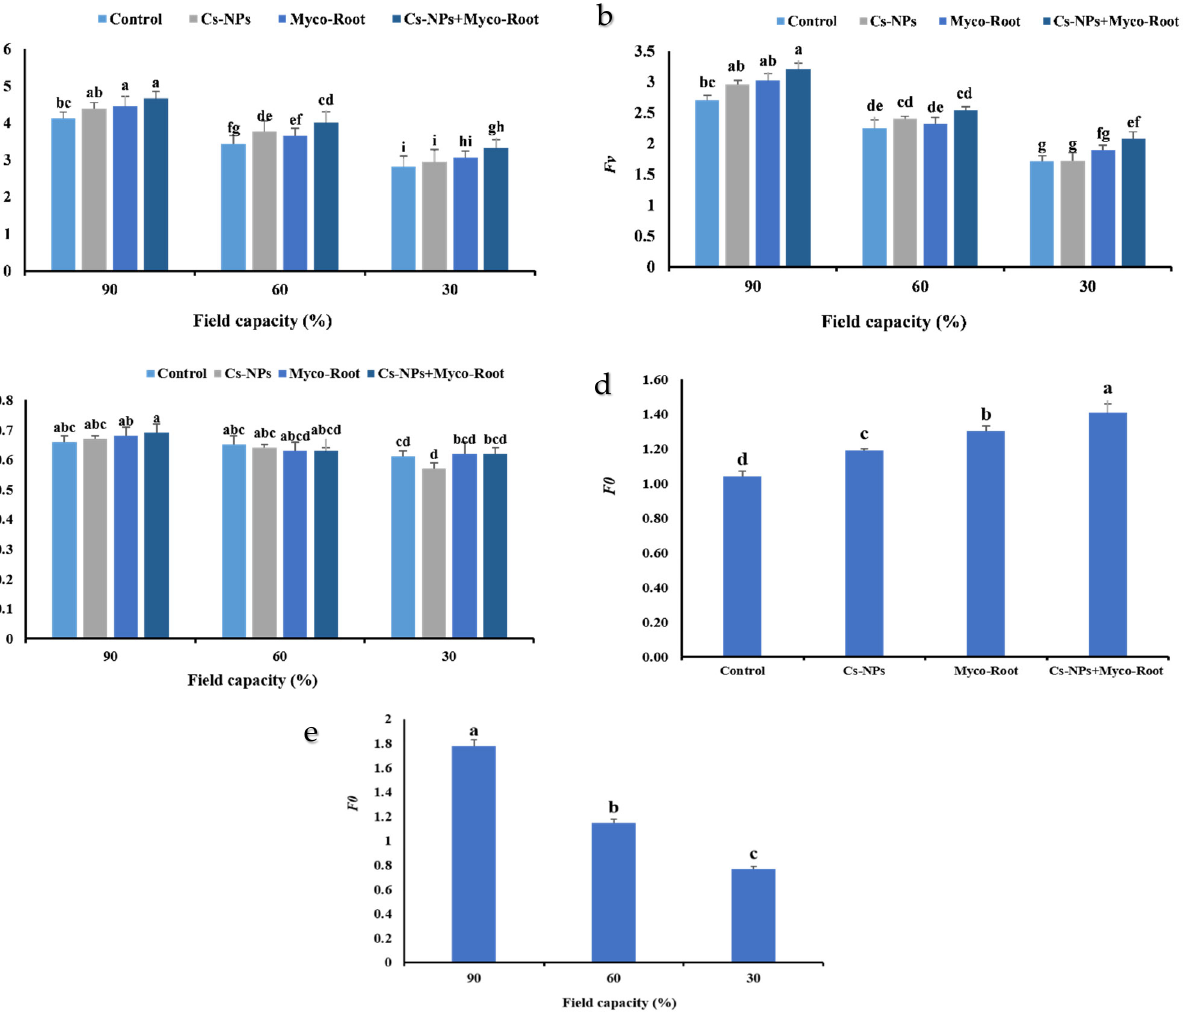
Ns, * and ** indicate no significant difference, significant at 5% probability level and significant at 1% probability level, respectively.